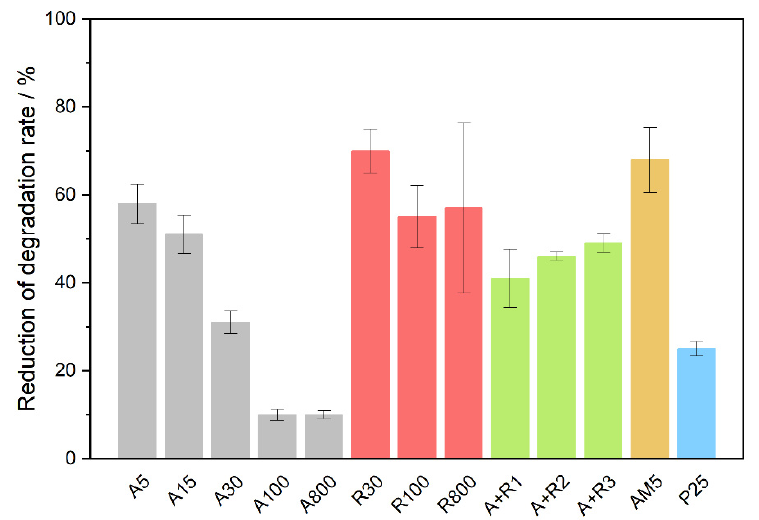
Figure 5. Reduction of rate constants of ampicillin degradation due to the isopropanol addition. The reduction was calculated as 100*(1 − k IPA /k).